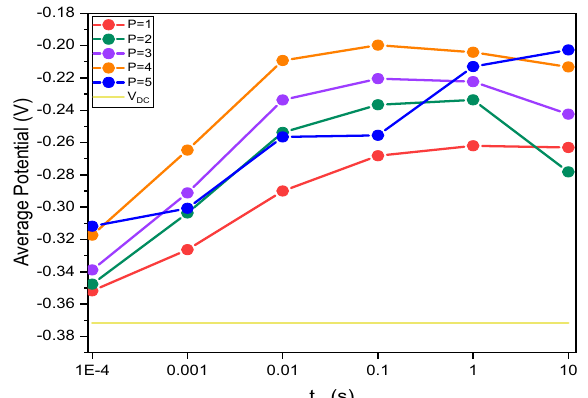
Figure 1. Average potential versus pulse time (t on ), measured for each value of P at different pulse times (t on = 10 −4 ; 10 −3 ; 10 −2 ; 10 −1 ; 1; 10 s) and for DC